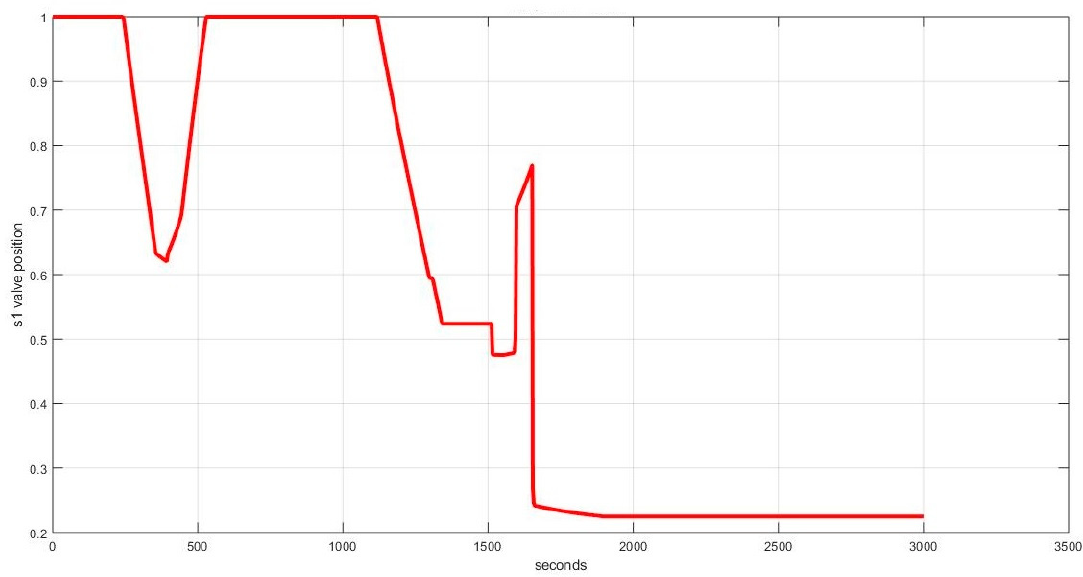
Figure 8. s1 control variable indicating the valve position for the case in Figure 6.